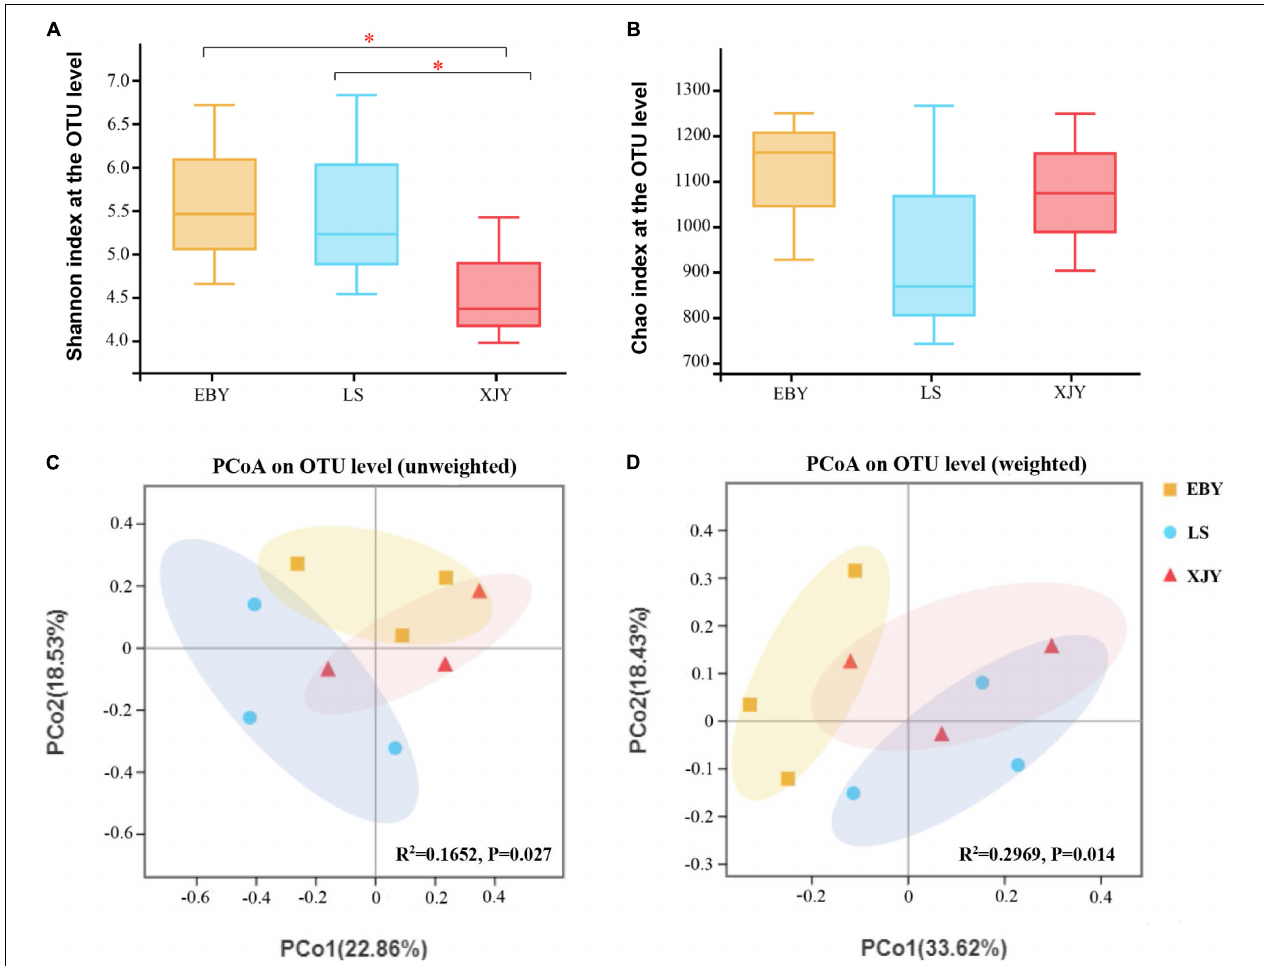
FIGURE 3 | Bacterial communities in the A. glabripenni s larval gut. Boxplots of (A) species diversity (Shannon index) and (B) species richness (Chao index). Significant differences in alpha-diversity were analyzed by Wilcoxon rank-sum test ( ∗ 0.01 < p ≤ 0.05). (C) Unweighted and (D) weighted UniFrac-based PCoA plots of bacterial communities. The significant differences in beta-diversities were analyzed using adonis analysis with 1,000 Monte Carlo permutations. EBY, Populus gansuensis ; LS, Salix babylonica ; XJY, Populus alba var. pyramidalis